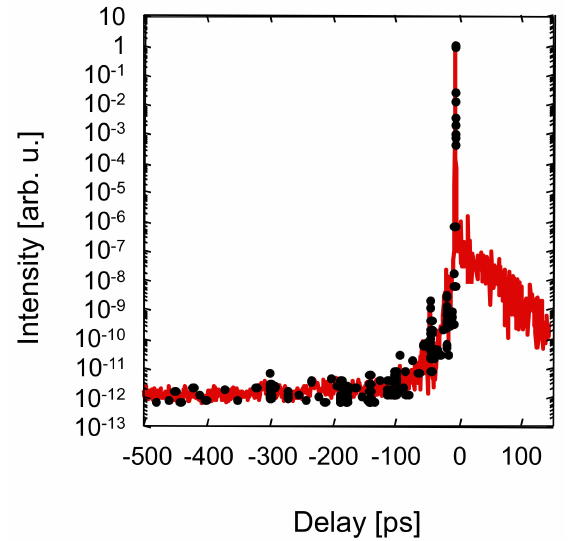
Figure 14. Measured contrast of the J-KAREN-P laser system with ~1 J (solid red line) and ~10 J (black, filled circles) output pulse energies by introducing wedged